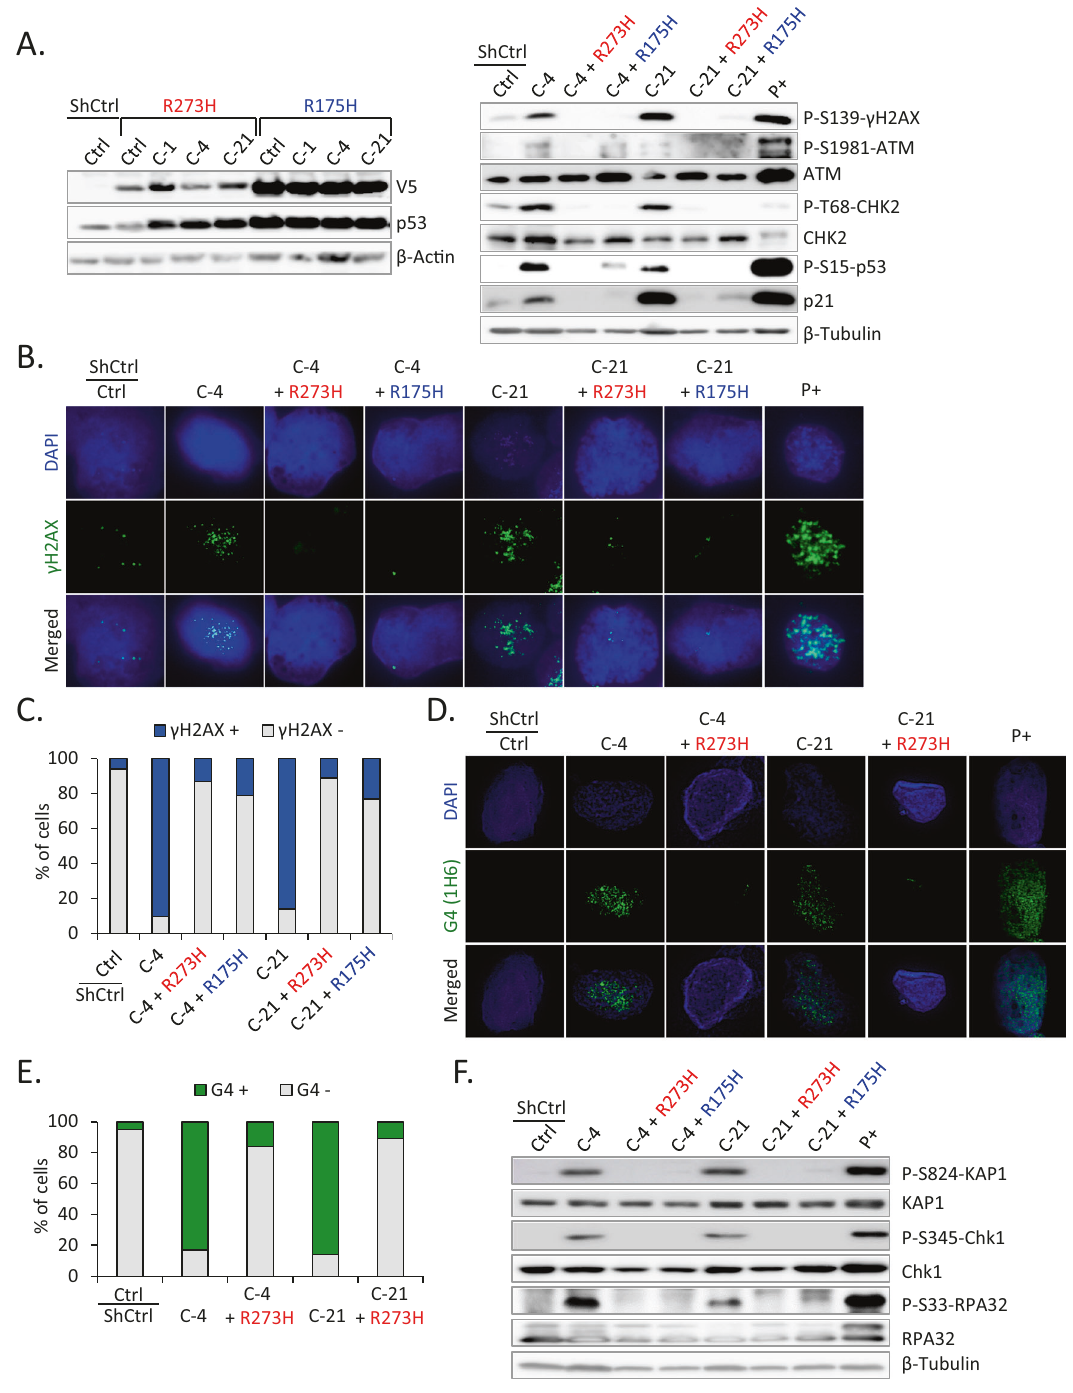
Fig. 3 p53 inactivation limits ATRX loss-induced G4 formation and RS in TP53 wt NGP cells. A Left panel, for p53 inactivation, C-terminally V5-tagged dominant-negative p53 mutants (p53_R273H or p53_R175H) or a control empty vector (ShCtrl) were stably introduced by lentiviral infection into Ctrl or ATRX KO NGP cells. Western blotting using anti-V5 and anti-p53 antibodies analyzed the expression levels of V5-tagged p53 mutants. β -Actin was used as a loading control. Right panel, immunoblots for the expression of DSB checkpoint proteins in cell lysates prepared from the indicated samples. p53 inactivation in ATRX KO NGP cells results in the loss of the DDR and p53-ATM checkpoint proteins. β -Tubulin was used as a loading control. As a positive control (P + ), parental NGP cells were treated with doxorubicin (0.5 μ g/mL) for 24 h. B , C γ H2AX IF indicates decreased DDR after p53 inactivation in ATRX KO NGP cells. NGP cells treated with doxorubicin (0.5 μ g/mL, 24 h) were used as the positive control. C Quanti fi cation of γ H2AX + cells among 100 cells analyzed in ( B ). D , E IF staining of G4 (1H6) in the indicated cells. As a positive control (P + ), parental NGP cells were treated with the DNA G-quadruplex stabilizer CX-5461 (50 nM) for 24 h and stained with the anti-G4 (1H6) antibody. Nuclei are counterstained with DAPI (blue). E Quanti fi cation of G4 + cells among 100 cells analyzed in ( D ). F The RS markers p-KAP1, p-Chk1, and p-RPA32 were not induced in p53 -inactivated ATRX KO NGP cells, representing a reduction in RS. β -Tubulin was used as a loading